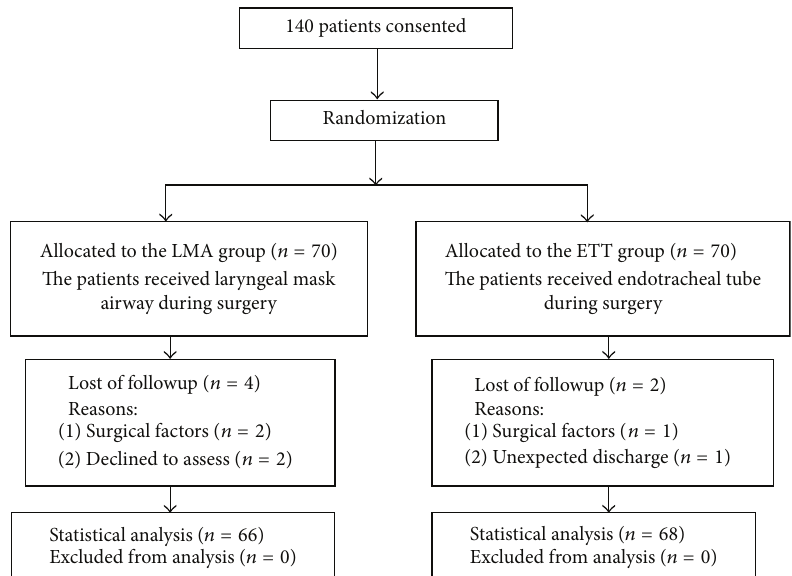
Figure 1: Flow diagram (progress steps of the trial: selection and randomization of elective intranasal patients to receive the laryngeal mask airway or endotracheal tube).